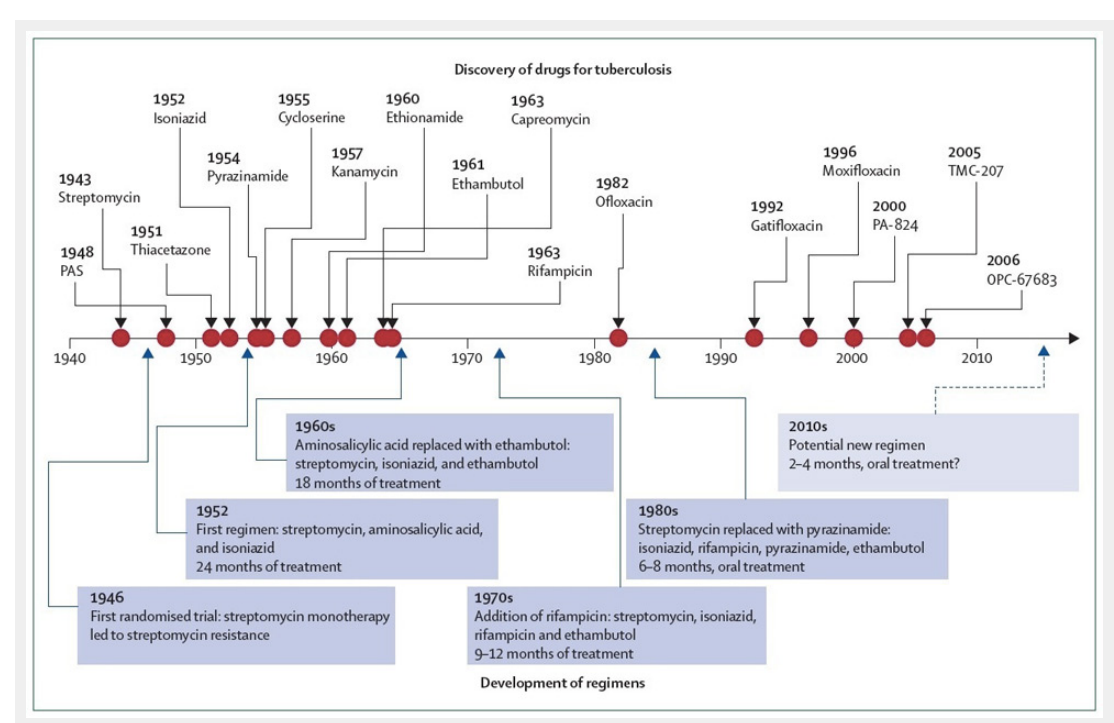
Figure 1 History of drug discovery and development of treatment regimens for tuberculosis. Compounds that are in the early-stage of development, but for which there are no published human proof-of-concept data, are not shown. Arrow with dashed line represents a possible future regimen. Red dots represent when the drugs were first reported. (From [51]: Ma Z, Lienhardt C, McIlleron H, Nunn AJ, Wang X. Global tuberculosis drug development pipeline: the need and the reality. Lancet. 2010;375(9731):2100–9. Copyright 2012, with permission from Elsevier, Oxford, UK.)